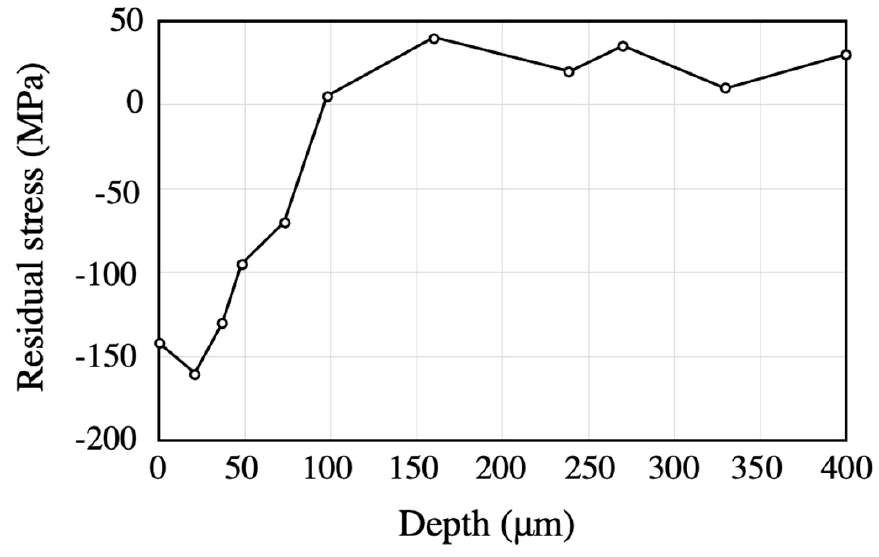
Figure 1. Depth profile of residual stress of shot-peened specimen.